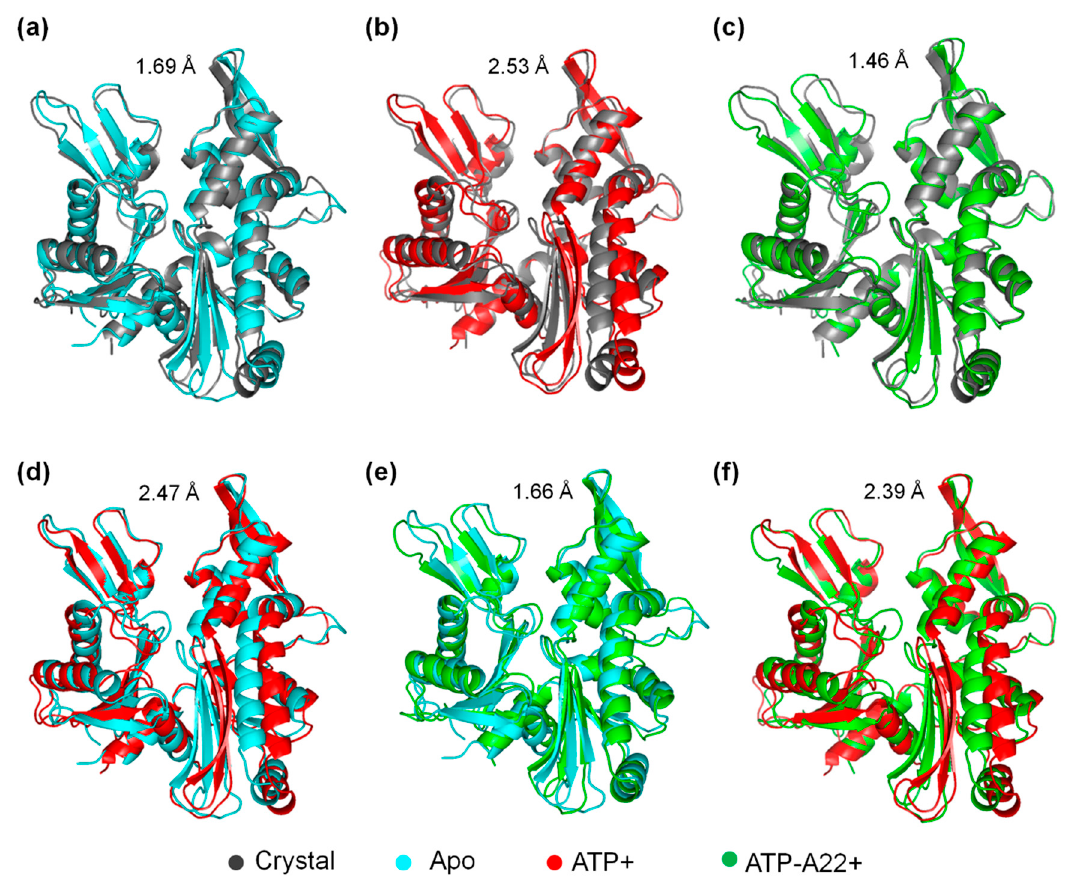
Figure 4. Pair-wise alignment of the crystal, apo, ATP+, and ATP-A22+ structures with corresponding RMSDs. ( a ) Alignment of apo/crystal structures. ( b ) Alignment of ATP+/crystal structures. ( c ) Alignment of ATP-A22+/crystal structures. ( d ) Alignment of apo/ATP+ structures. ( e ) Alignment of apo/ATP-A22+ structures. ( f ) Alignment of ATP+/ATP-A22+ structures.